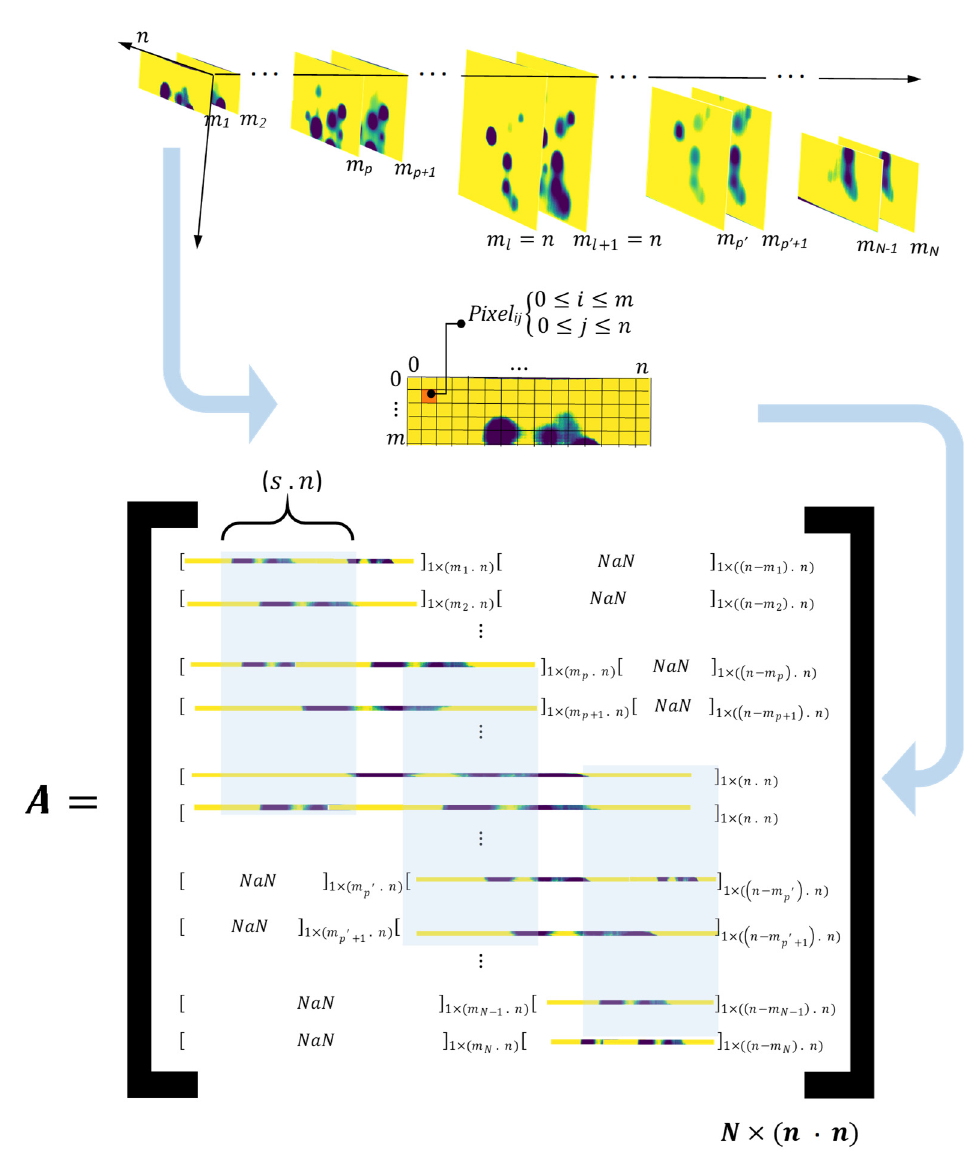
Figure 10. Generating the PCA input matrix from time-transient 3D array of DRR selected images. After performing PCA on equal segments, each PCA by-product vector is reshaped into its original 2D array (image) of size ( s × n ) . Figure 11 demonstrates the PCA result for four segments of the test piece surface compared to the result of PCA on originally captured thermal images.